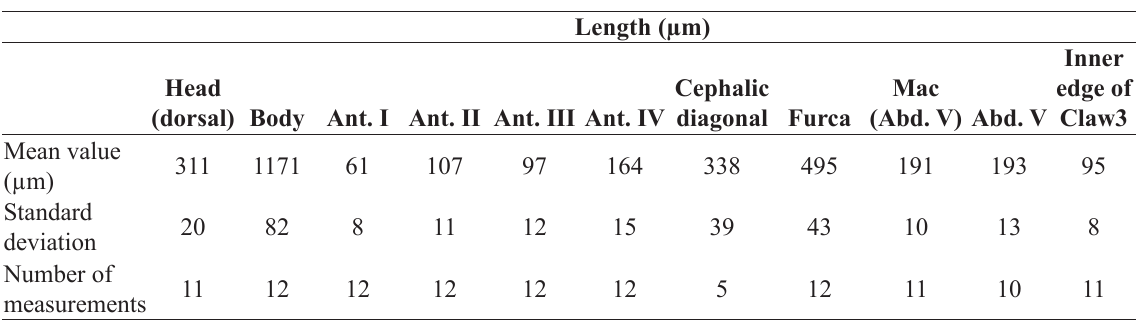
Table 1. Body measurements of Desoria calderonis sp.